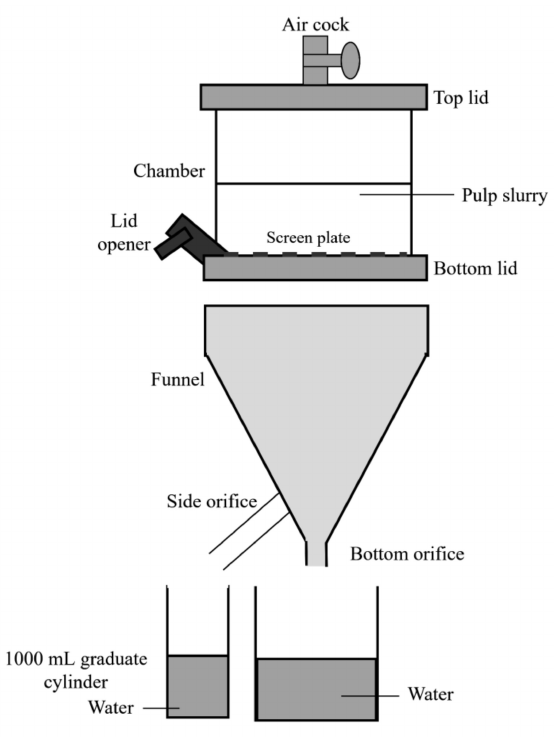
Figure 3. Pulp freeness measurement.